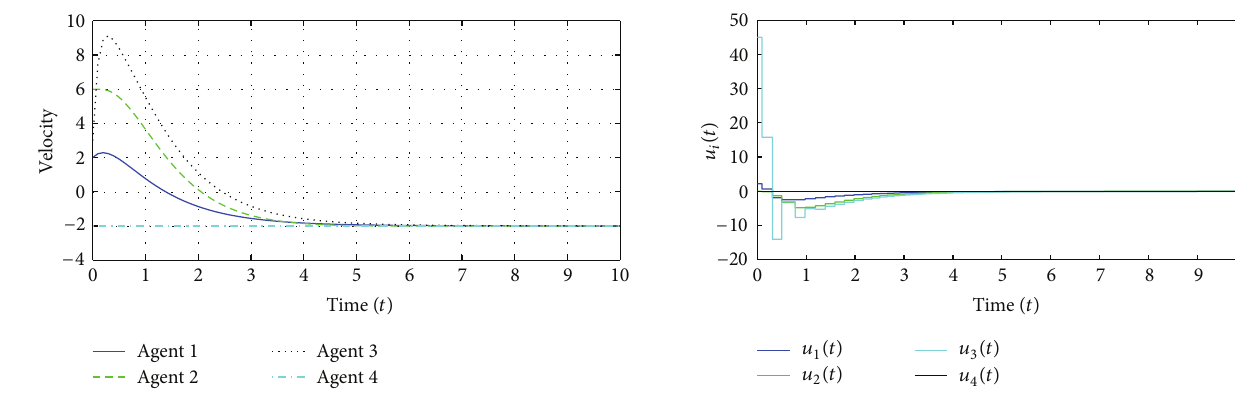
Figure 5: Evolution of the consensus controllers 𝑢 𝑖 (𝑡) for 𝑖 = 1,...,4 .